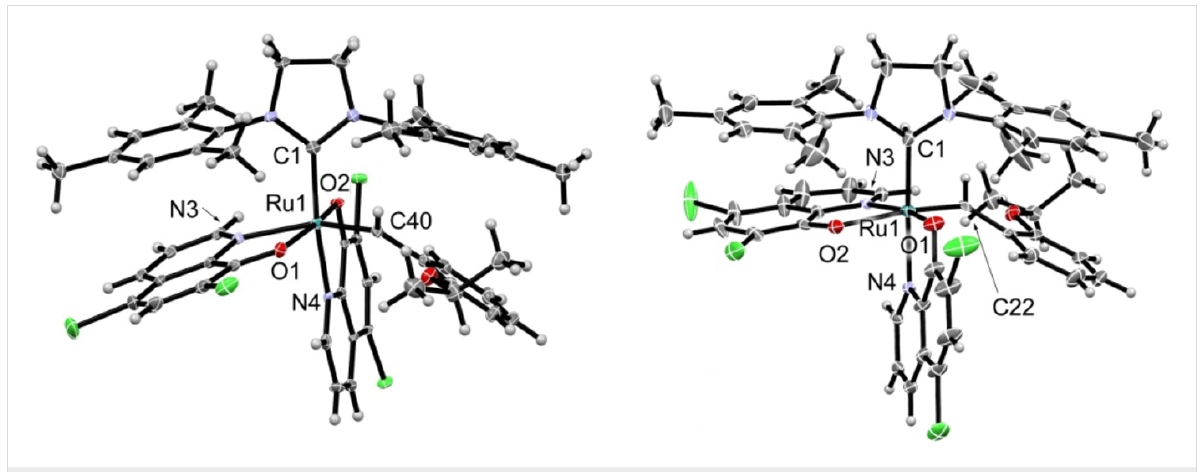
Figure 1: Solid state structure of complexes 2a and 2b as retrieved from single crystal X-ray diffraction.